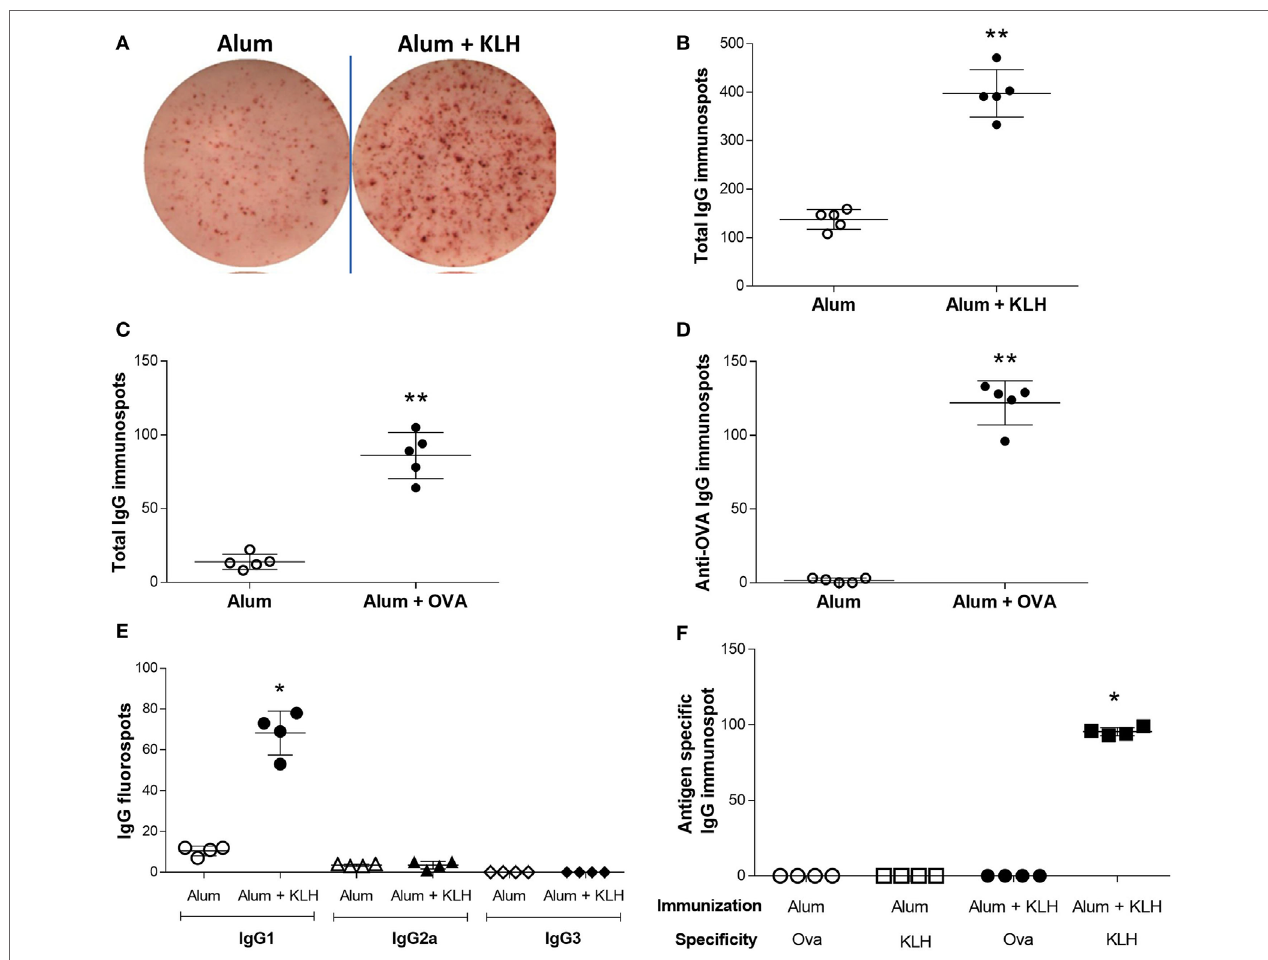
FigUre 2 | Dorsal root ganglion (DRG) neurons release antigen-specific IgG 1 . (a) Representative images from total IgG ELISpot assay performed on DRG neurons isolated from alum-injected and alum + KLH-immunized mice. Quantitation of total IgG-releasing DRG neurons isolated from (B) alum-injected and alum + KLH- immunized mice ( n = 5 per group) or (c) alum-injected and alum + ovalbumin (OVA)-immunized mice ( n = 5 per group) using the ELISpot assay (mean ± SD); ** P < 0.01 vs . alum-injected (Mann-Whiteny test). (D) Quantitation of anti-OVA-releasing DRG neurons isolated from alum-injected and alum + OVA-immunized mice ( n = 5 per group) using the Anti-OVA IgG ELISpot assay (mean ± SD); ** P < 0.01 vs. alum-injected (Mann-Whitney test). (e) Quantification of IgG 1 -, IgG 2a -, and IgG 3 -specific FluoroSpots from DRG neurons isolated from alum-injected and alum + KLH-immunized mice using the IgG isotype FluoroSpot assay; (mean ± SD, n = 4 per group); * P < 0.05 vs . alum-injected (Mann-Whitney test). (F) Quantification of anti-OVA- and anti-KLH-specific IgG immunospots from DRG neurons isolated from alum-injected and alum + KLH-immunized mice (mean ± SD, n = 4 per group) using the antigen-specific ELISpot assay; * P < 0.05 vs . alum-injected for each antigen (Mann-Whitney